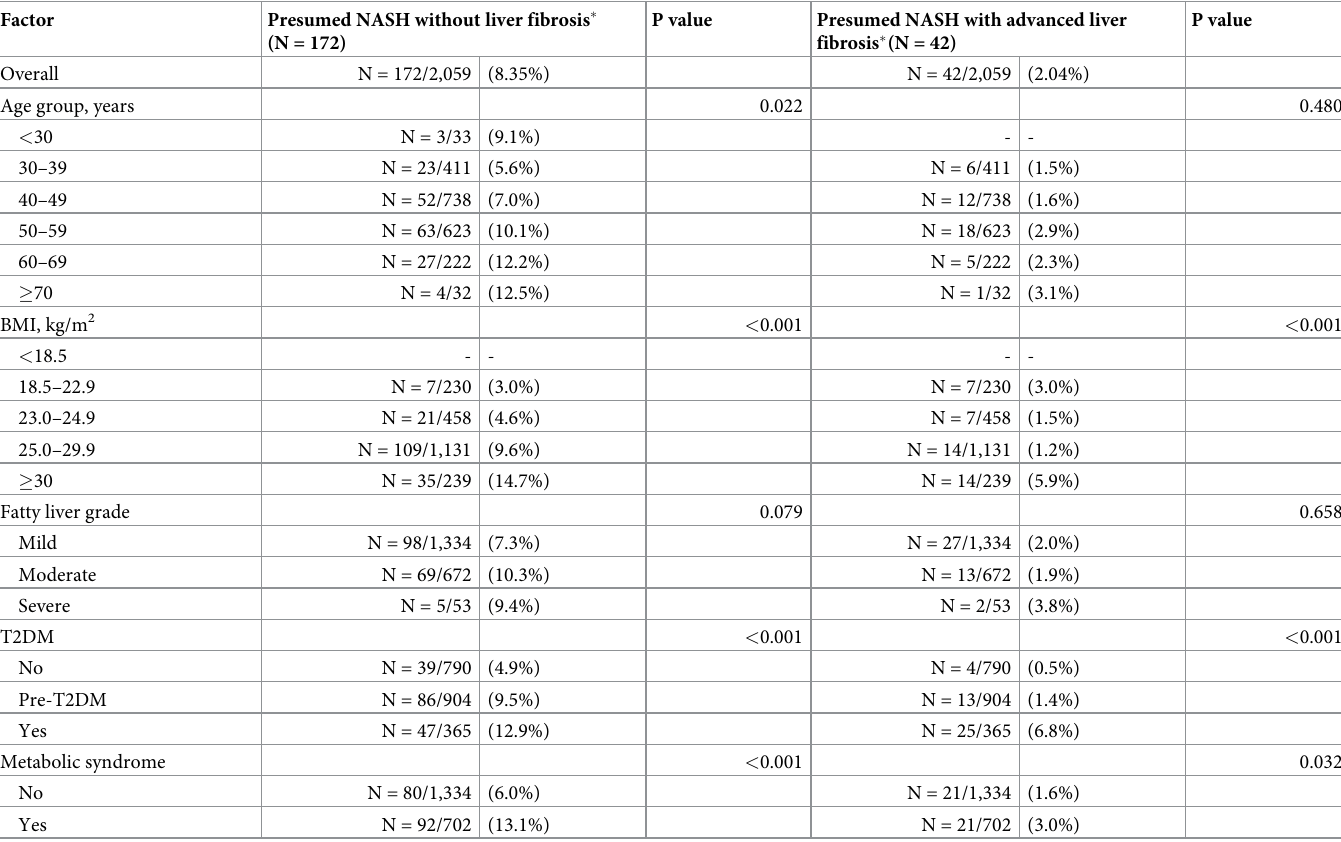
Table 4. Prevalence of nonalcoholic steatohepatitis (NASH) and advanced liver fibrosis according to characteristics of the study subjects with fatty liver (N =